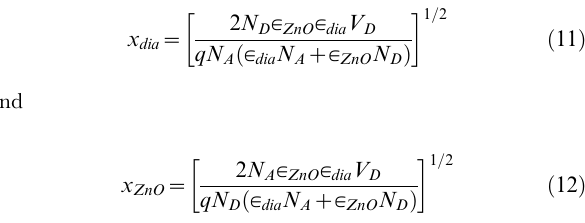
Figure 5. The ratio of I UV /I dark obtained from current measure- ments.